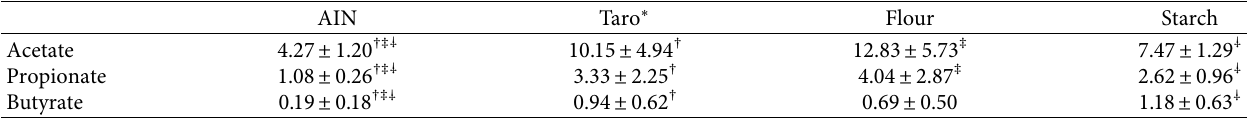
∗ Taro flour and taro starch together. †‡† Symbols within rows that are equal indicate significant differences ( p < 0 .